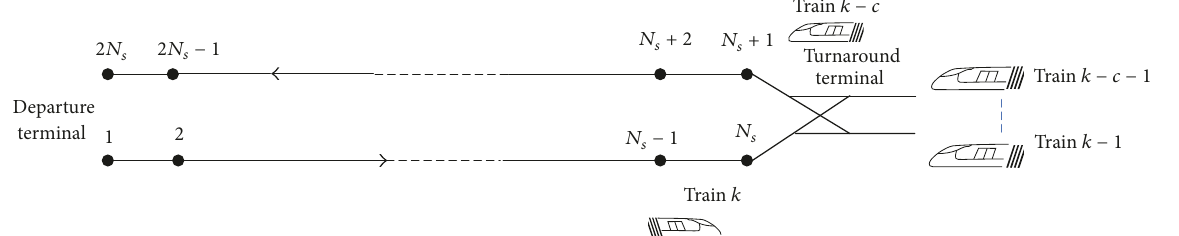
Figure 1: Illustration of a bidirectional metro